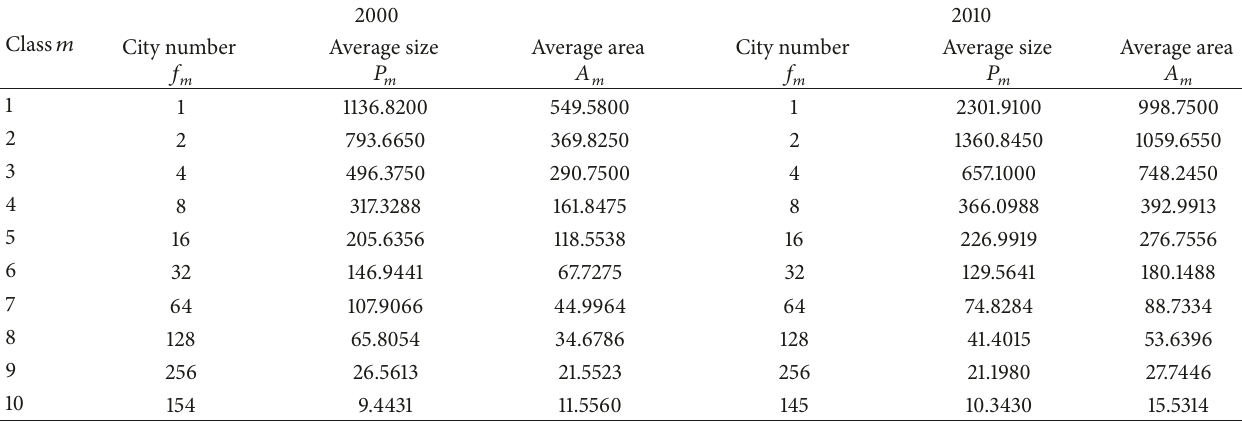
Table 1: The examples of reconstructed self-similar hierarchies of Chinese cities in 2000 and 2010.